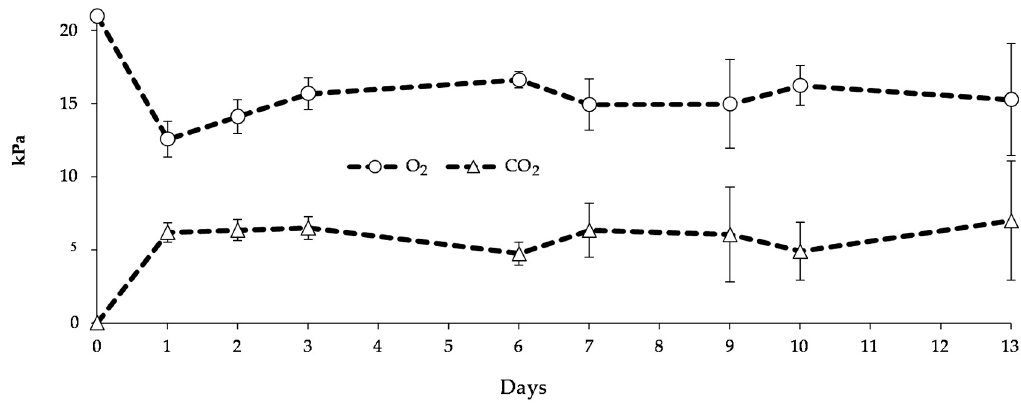
Figure 3. Changes in gas composition inside Active-pMA bags of blueberries (cv Rebel) stored for 13 days at 8 °C. Data are mean values ( n = 3) ± standard deviation. pMA: passive modified atmosphere packaging.